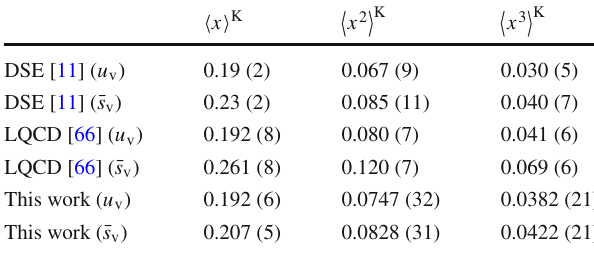
Table 5 Comparisons of our predicted moments (cid:6) x (cid:7) , distributions of the kaon with some other theoretical calculations, at Q 2 = 27 GeV 2 . The errors in the table indicate the 1 σ